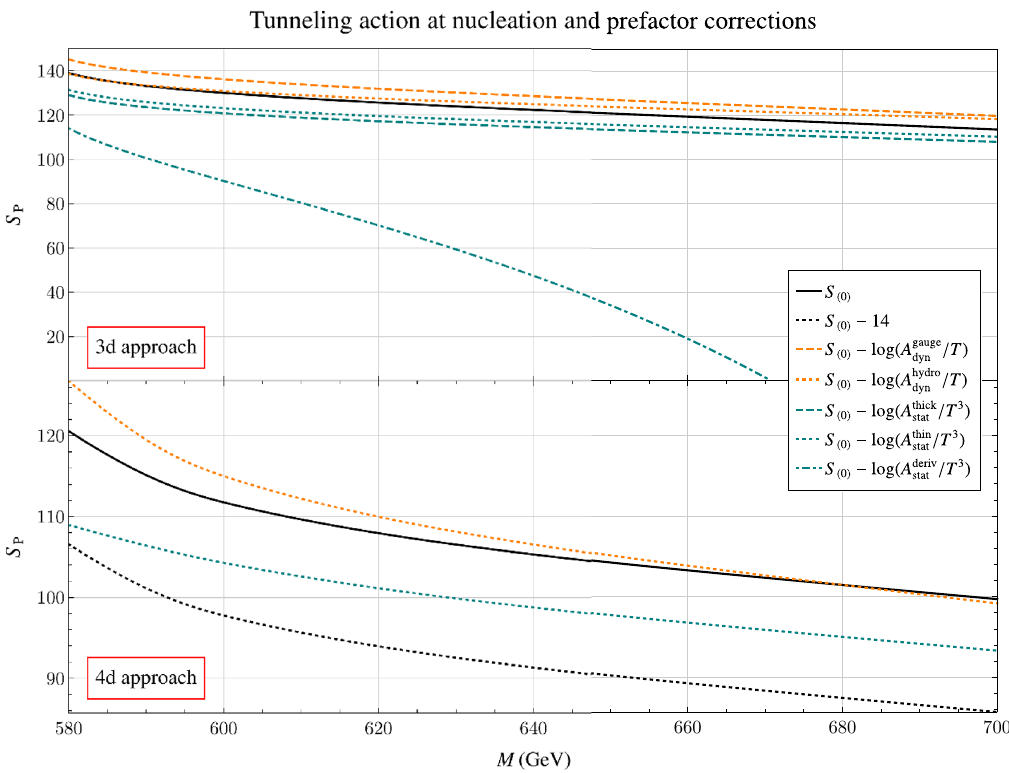
Figure 9 . The tunnelling action at nucleation in the 3d (top panel) and 4d (bottom panel) approach, shown in black at LO in the ~ -expansion, S . Also shown are prefactor corrections (0) which, for each M , are all evaluated at the nucleation temperature calculated using our default prefactor approximation. The full prefactor factorises into dynamical (orange) and statistical (cyan) parts; see eq. (3.14). More details of these approximations can be found in appendix C. Note the large deviations from the LO result for the derivative approximation to the statistical